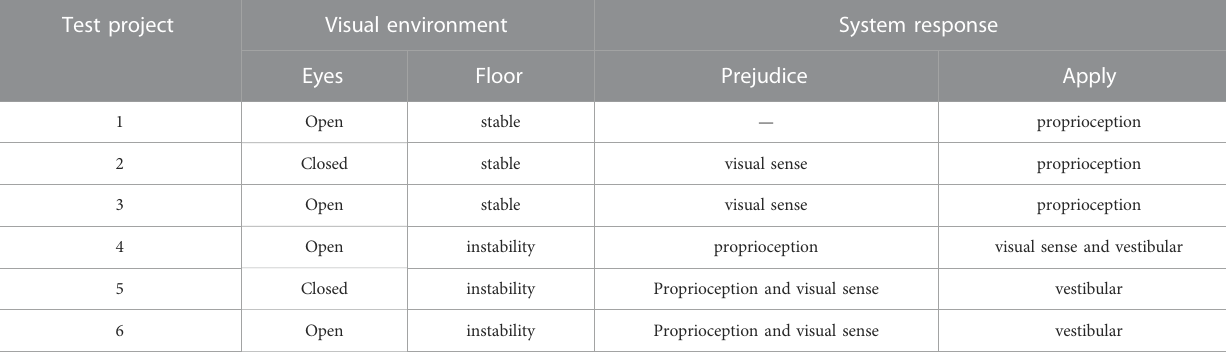
TABLE 1 Overview of the six SOT tests. Test